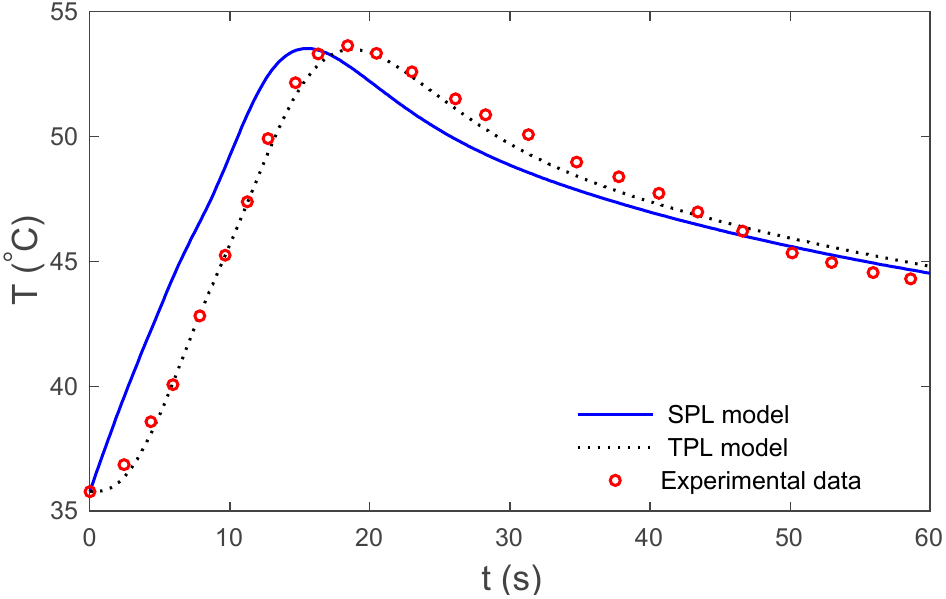
Figure 2. Variations in temperature versus the distance for the SPL and the TPL models.